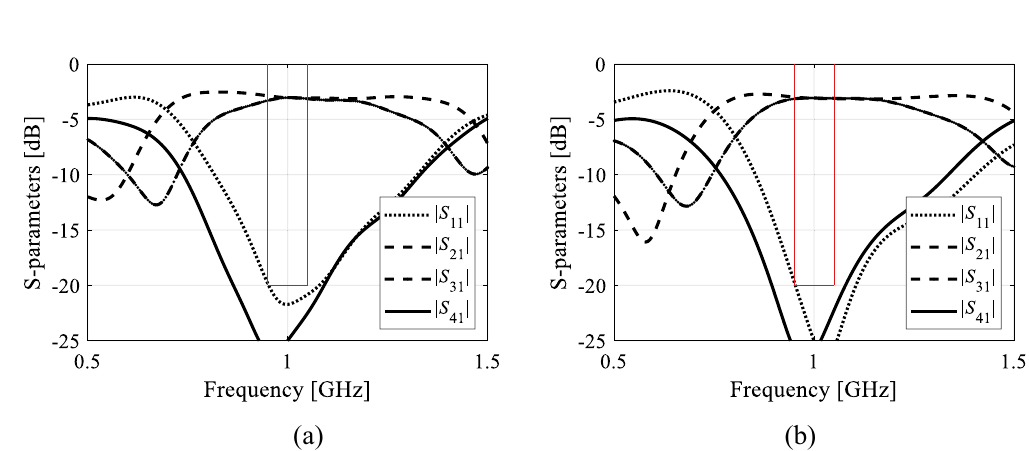
Figure 11. Circuit II: EM-simulated scattering parameters for two selected designs obtained using the proposed size reduction algorithm: ( a ) design 1 (footprint area 370 mm 2 ), ( b ) design 2 (footprint area 364 mm 2 ). Target operating frequency and bandwidth indicated using the vertical and horizontal lines,